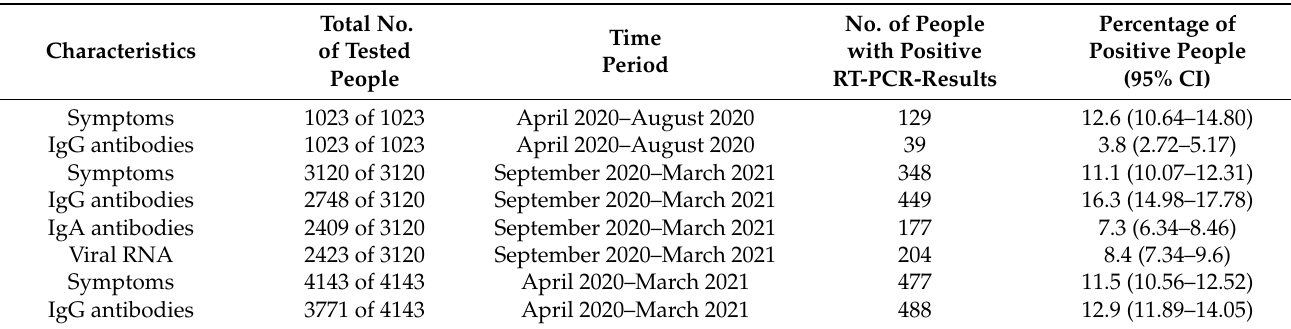
Table 1. Symptoms, seroprevalence, and RT-PCR positivity of participants without known COVID-19